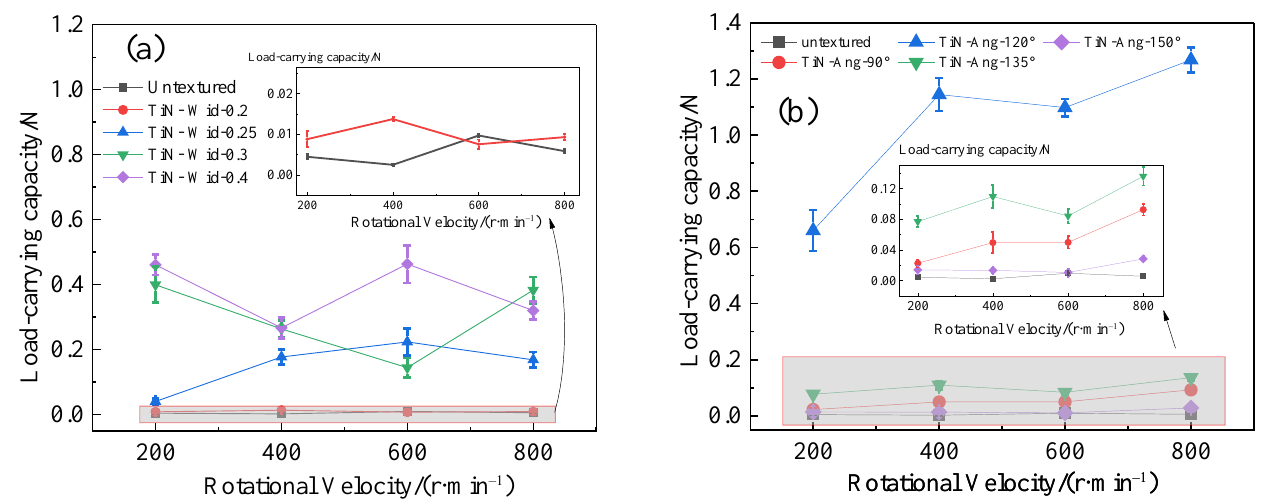
Figure 4. Load-carrying capacity of ( a ) different groove widths and ( b ) different groove angles with rotation